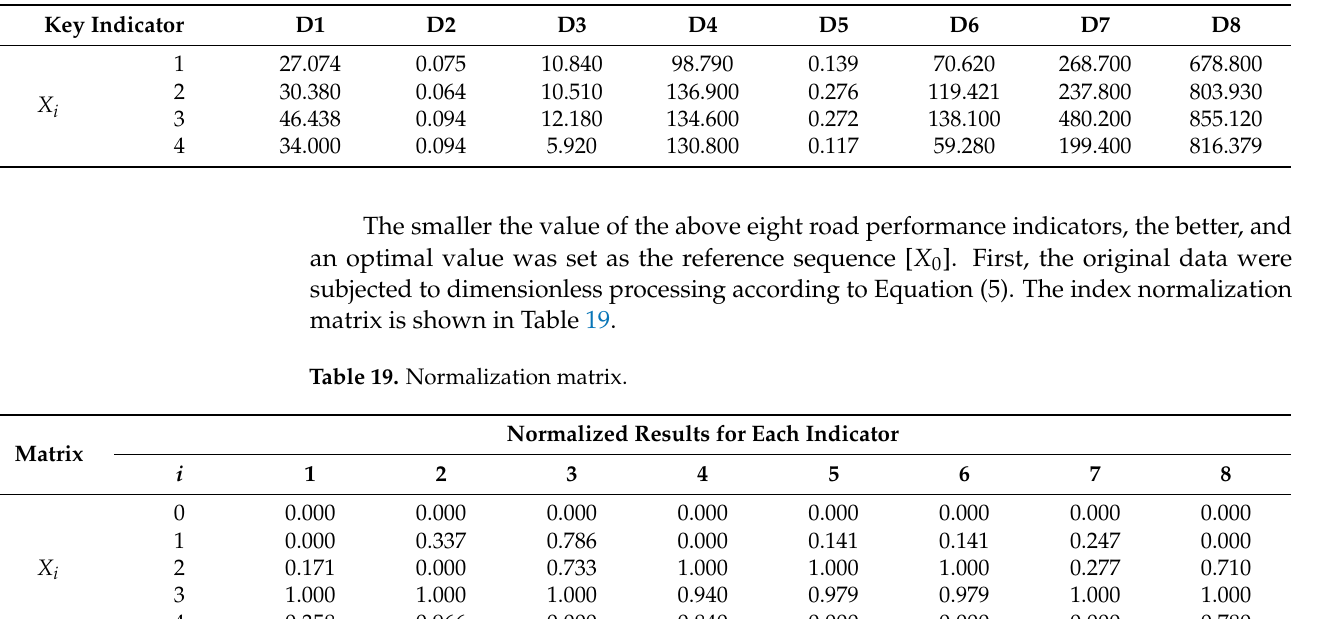
Table 18. Initial matrix of key parameters of pavement structure.